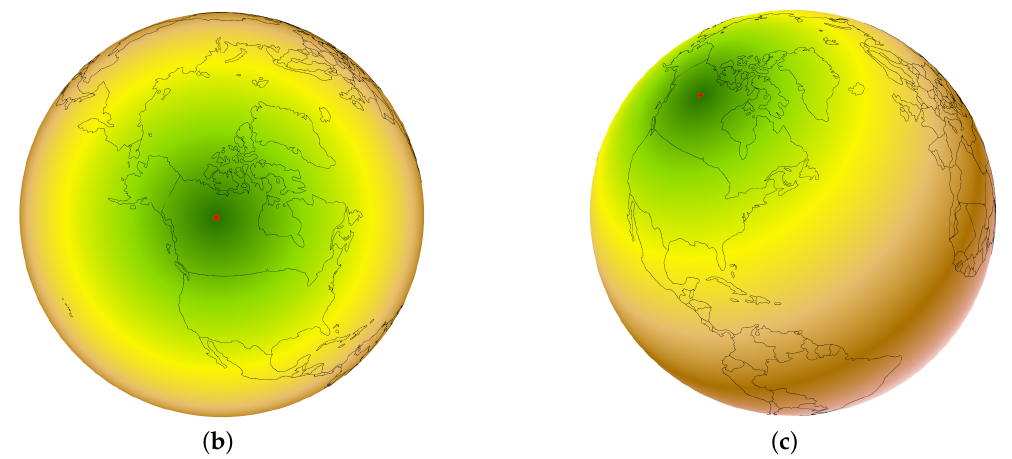
Figure 19. Distance transform from Yellowknife using ( a ) ArcGIS and planar distance calculations, ( b,c ) DGGS and our method.